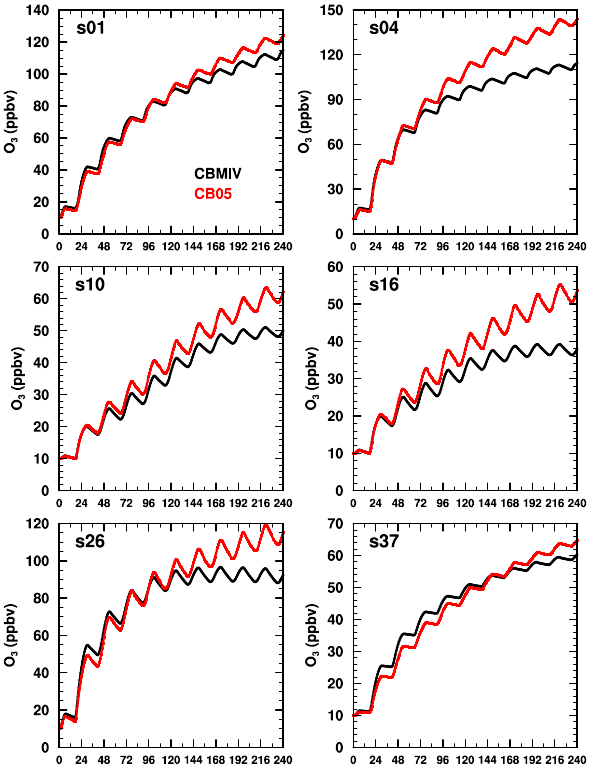
Fig. 2. Example scenario results from the simulation suite. Ozone Figure 2 . Example scenario results from the simulation suite. Ozone mixing ratios (ppbv) 6 mixing ratios (ppbv) for the base CB05 (red) and CBMIV (black) for the base CB05 (red) and CBMIV (black) mechanisms over the 240 hr simulation period. 7 8 mechanisms over the 240h simulation